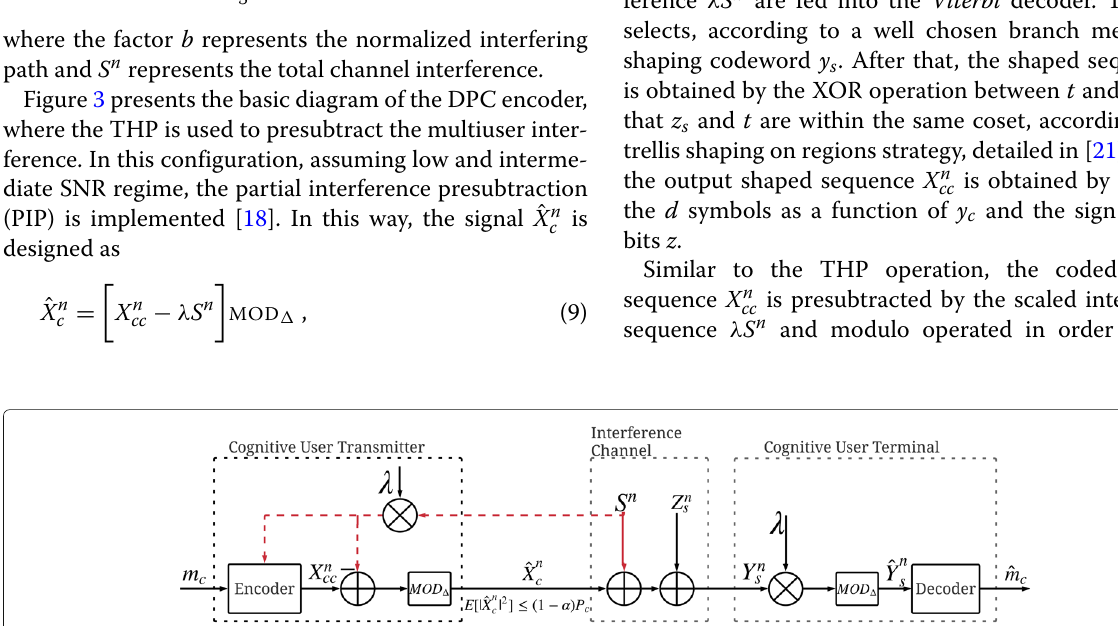
Fig. 3 DPC communication system by THP for multiuser